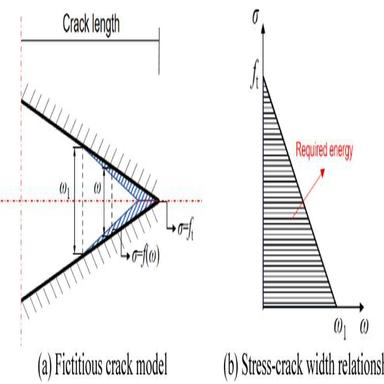
The fictitious crack model adapted from (a) the assumed stress distribution near the crack; (b) the assumed linear relationship between the stress and the crack opening displacement.